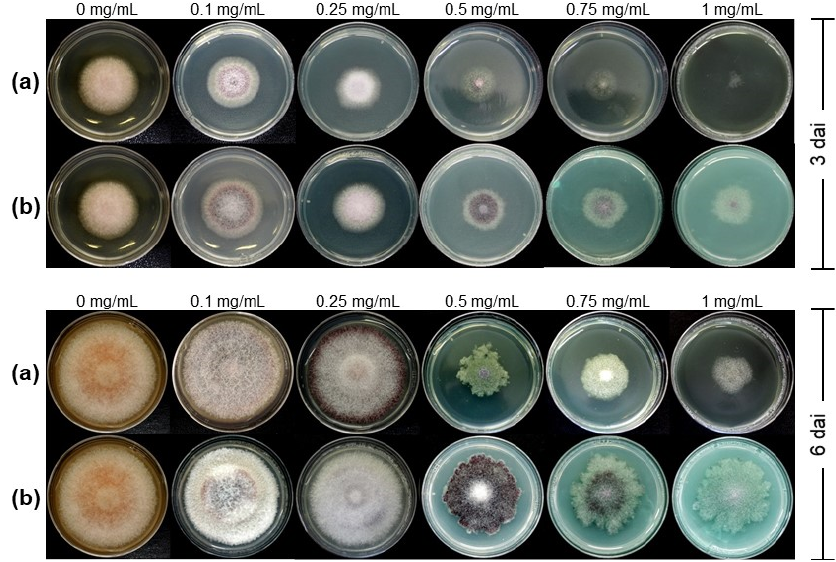
Figure 1. F. kuroshium mycelial growth inhibition assays. The colony morphology of F. kuroshium wild-type strains grown on plates with PDA culture medium supplemented with different concentrations (0 mg/mL (control), 0.1, 0.25, 0.5, 0.75, and 1 mg/mL) of ( a ) Cu-NPs and ( b ) cupric hydroxide at 3 and 6 days after inoculation (dai).